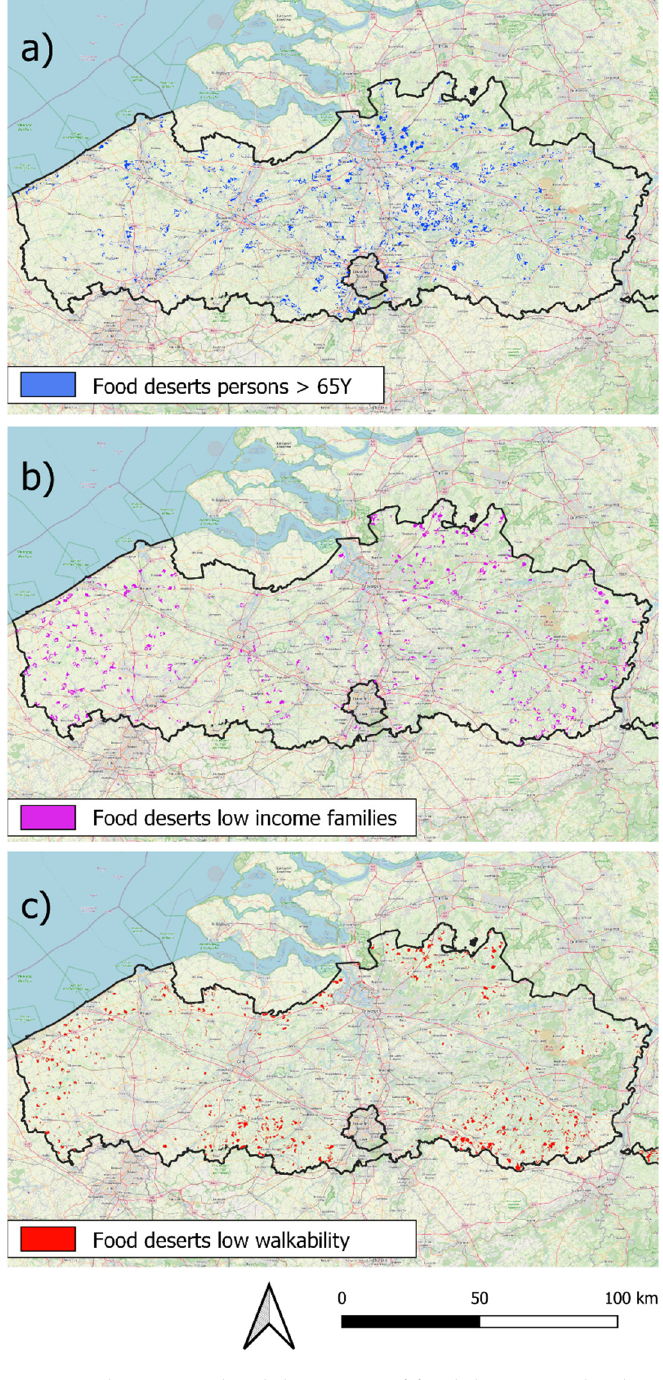
Figure 4. The geographical dispersion of food deserts in Flanders (data 2020). ( a ) Food deserts in areas with a high number of people > 65Y; ( b ) food deserts in areas with a high number of families with low income; ( c ) food deserts in areas with low walkability.